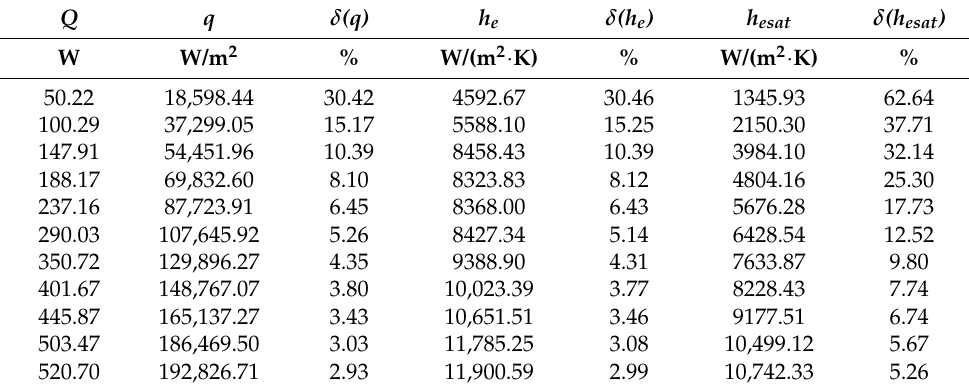
Table 8. Uncertainty values of the computed heat transfer coefficients for LHPs with stainless steel wicks.